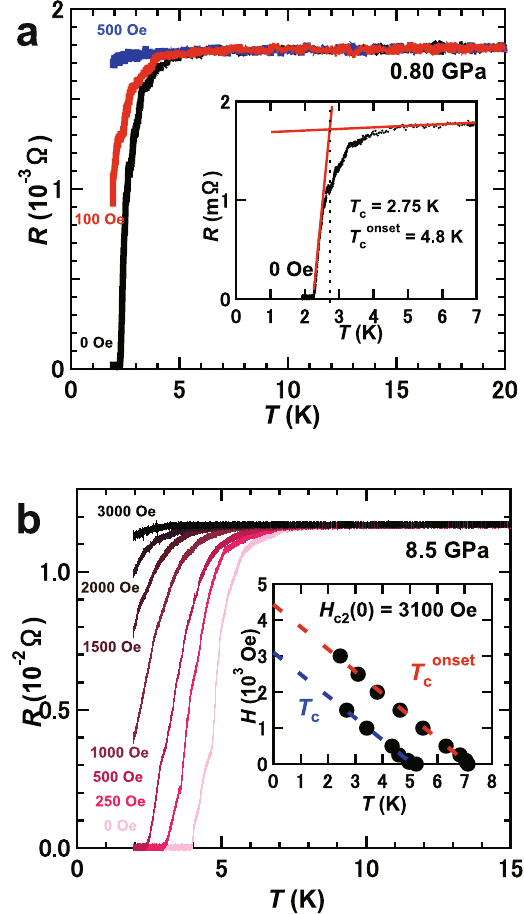
Figure 4. R – T plots of Ca 0.5(2) Sr 0.5(2) C 6 at different H’ s under pressure of ( a ) 0.80 GPa and ( b ) 8.5 GPa. Inset of ( a ) shows how to determine T c , and inset of ( b ) shows plots of H – T conset and H – T c for Ca 0.5(2) Sr 0.5(2) C 6 . The H – T conset refers to H c2 – T